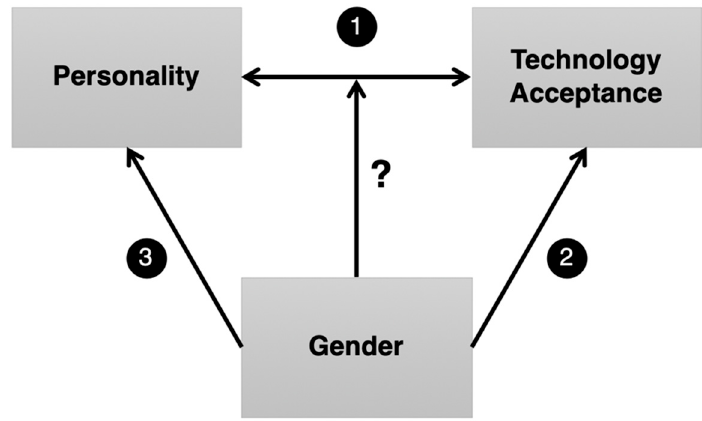
Figure 1. Conceptual Framework of Literature Review. 1: Research Stream 1 = personality and TA associations; 2: Research Stream 2 = gender di ff erences in TA, 3: Research Stream 3 = gender di ff erences in personality.